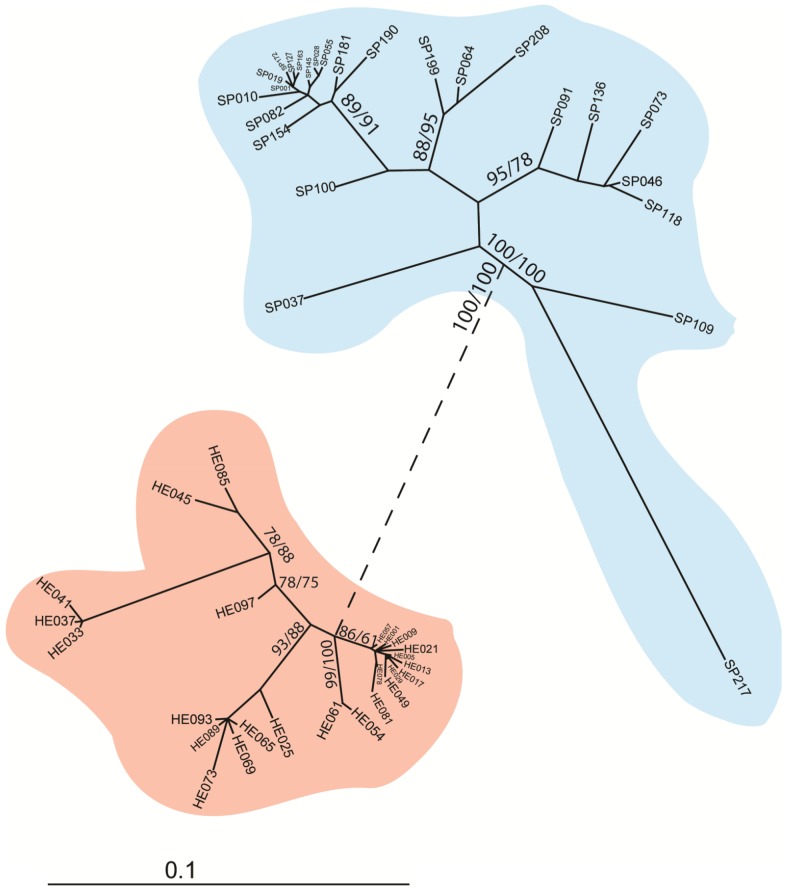
Phylogenetic relationship between 25 He185/333 and Sp185/333 cDNAs.
He185/333 clades are highlighted in a darker shade than Sp185/333 clades. The phylogenetic tree shows clearly that 185/333 sequences cluster according the species they originated from. The main branch separating the two clades was shortened for display purposes (dashed line). It is representative of the corrected genetic distance of 0.27949 and is supported by 100% of bootstraps. Hence, all sequences within one species had lower genetic distances to each other (highest value 0.07705 for He185/333 and 0.12781 for Sp185/333, respectively) than to any sequence from the opposite species. Boot Strap values are shown next to the branches with the ordering NJ/MP. Values below 50 are not displayed.